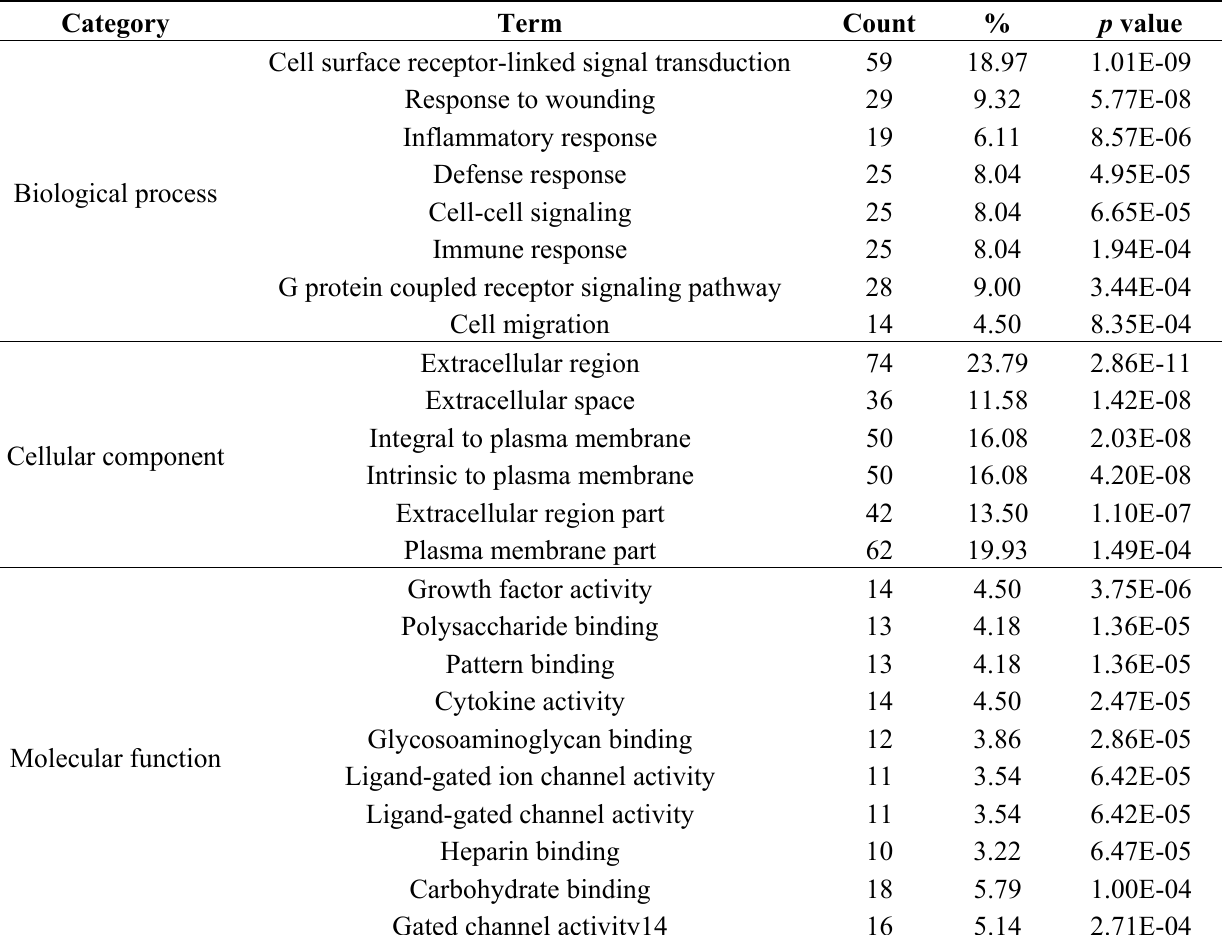
Table 1. Enrichment analysis of E4-ORF3 target